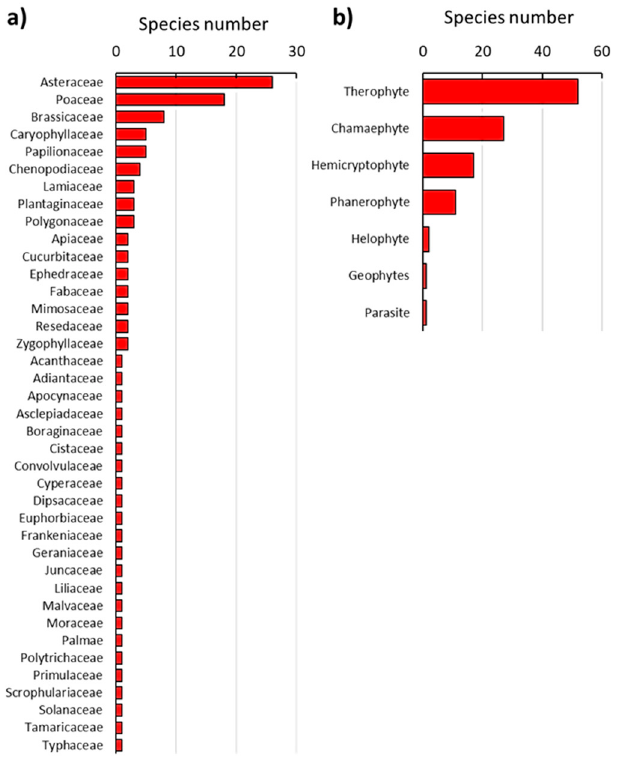
Figure 2. Plant families of the recorded plant species ( a ) and the life forms according to Raunkiaer’s classification ( b ).